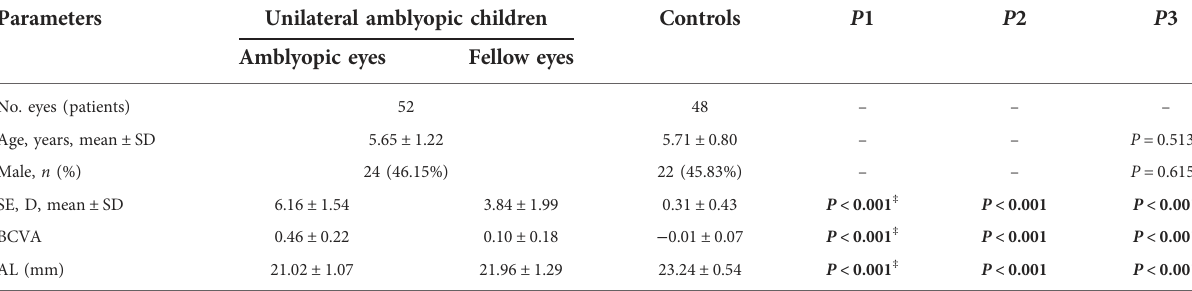
TABLE 1 Demographic and ocular characteristics. Parameters